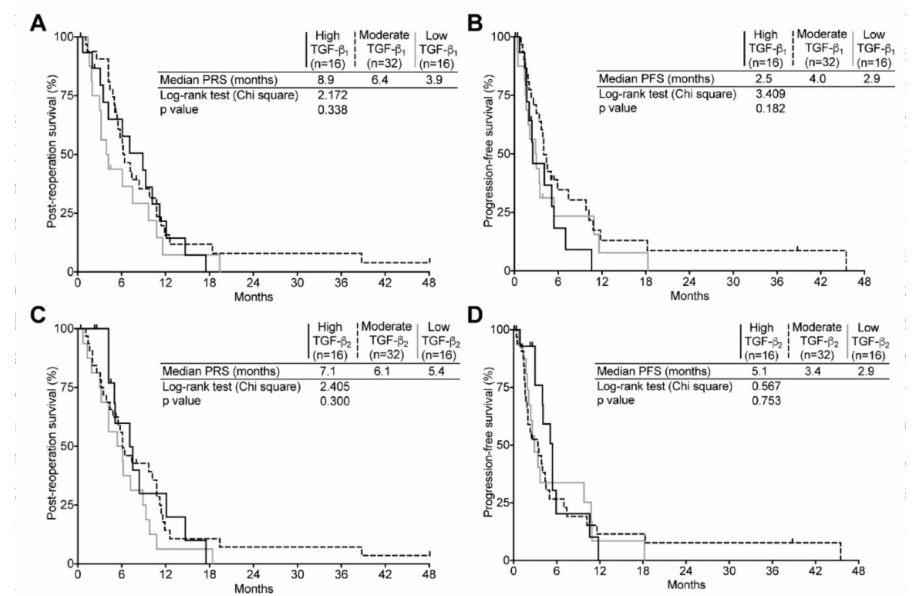
Figure 5. Correlation of TGF- β 1 and TGF- β 2 expression level with recurrent GBM patient outcome. Kaplan–Meier estimates of overall survival and progression-free survival in recurrent GBM according to three subgroups (high, black line; moderate, dashed line; low, gray line) of TGF- β 1 ( A , B ) or TGF- β 2 ( C , D )